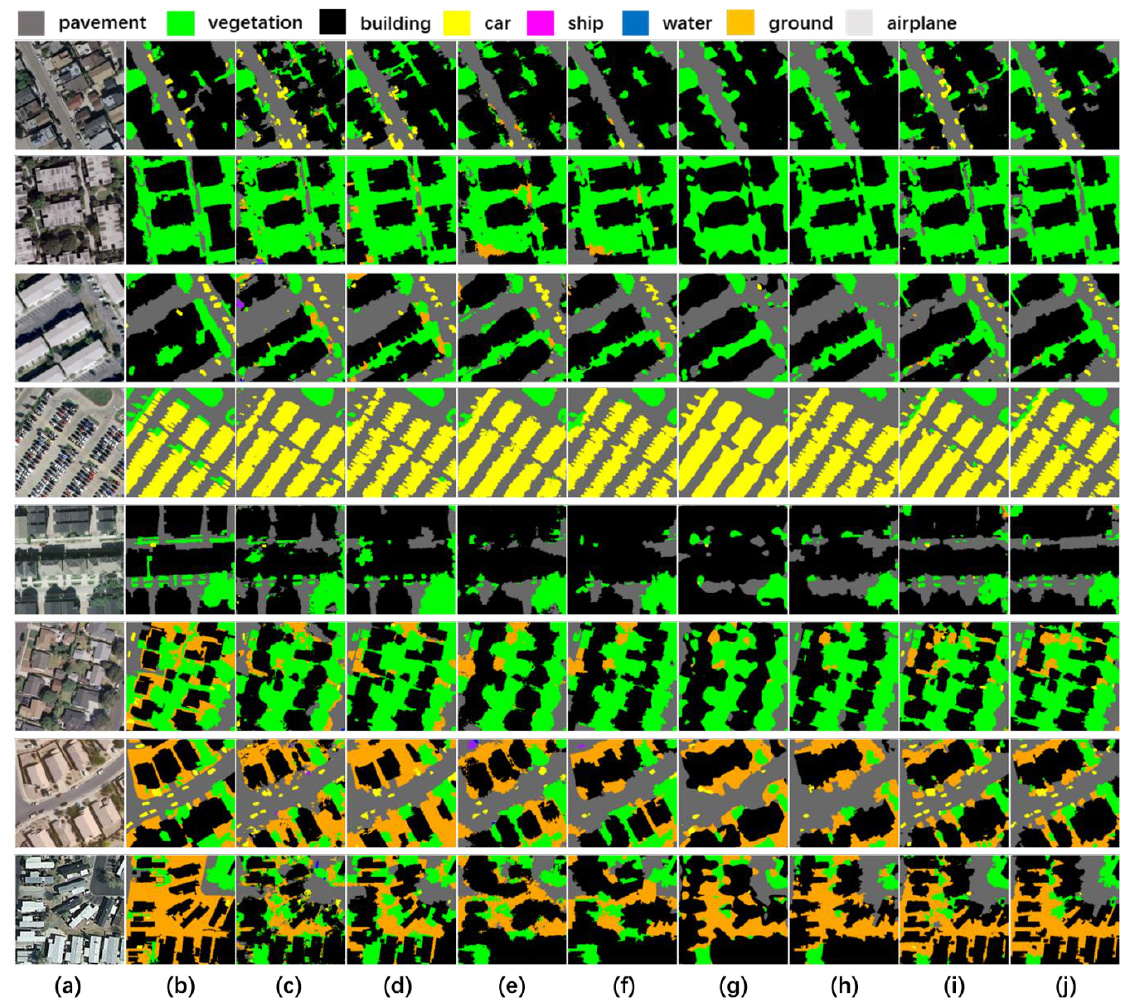
Figure 10. The visible semantic segmentation of the UCM dataset. ( a ) and ( b ) are raw images and ground truth respectively. ( c ) and ( d ) are the results of U-Net and the results of DSSN-GCN V1, respectively. The results of SegNet and the results of DSSN-GCN V2 are shown on ( e ) and ( f ), respectively. ( g ) and ( h ) present the results of DeepLab V3+ and the results of DSSN-GCN V3, respectively. The results of the proposed AttResUNet and AttResUNet-GCN (DSSN-GCN V4) are displayed on ( i ) and ( j ), respectively. Table 6. The OA (%) of semantic segmentation on the DeepGlobe